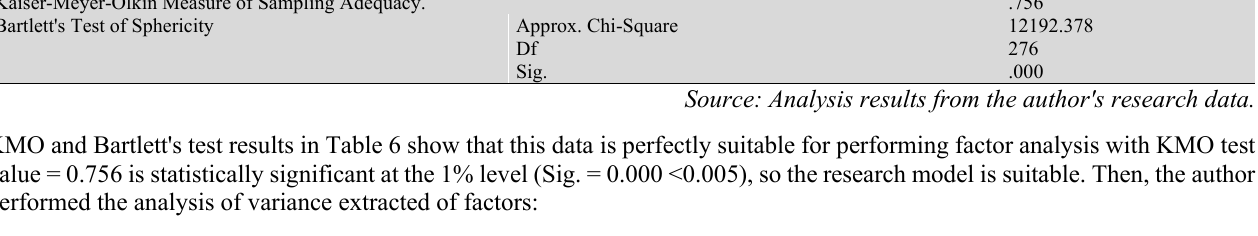
KMO and Bartlett’s Test KMO and Bartlett's Test Kaiser-Meyer-Olkin Measure of Sampling Adequacy.